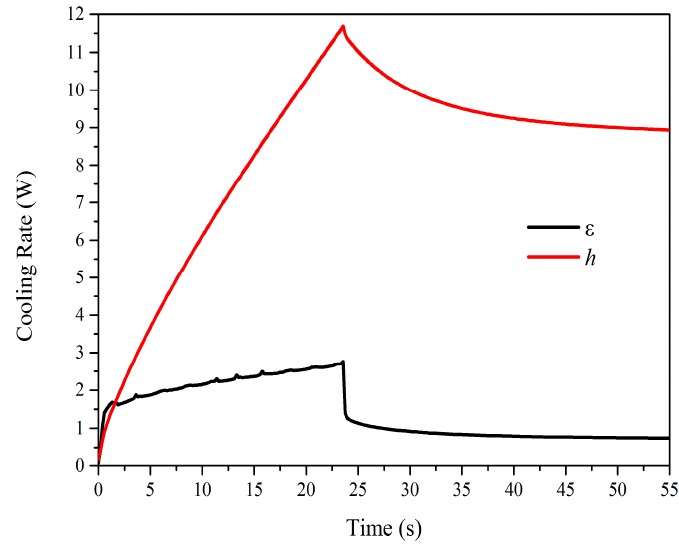
Figure 13. Overall heat transfer by convection and radiation for the GTA stainless steel welding.